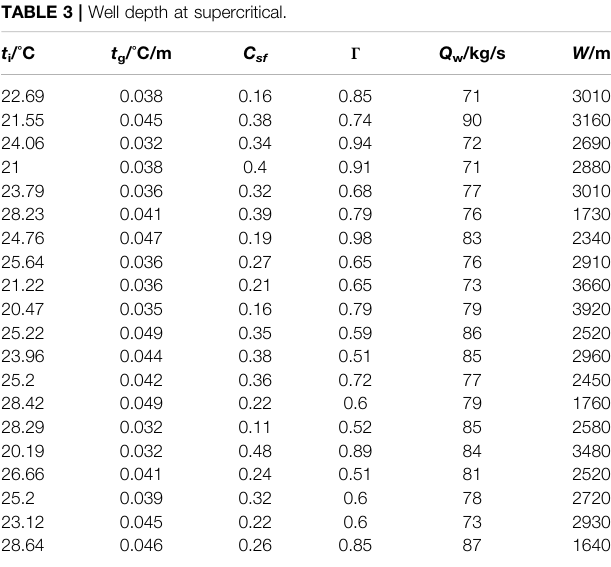
TABLE 3 | Well depth at